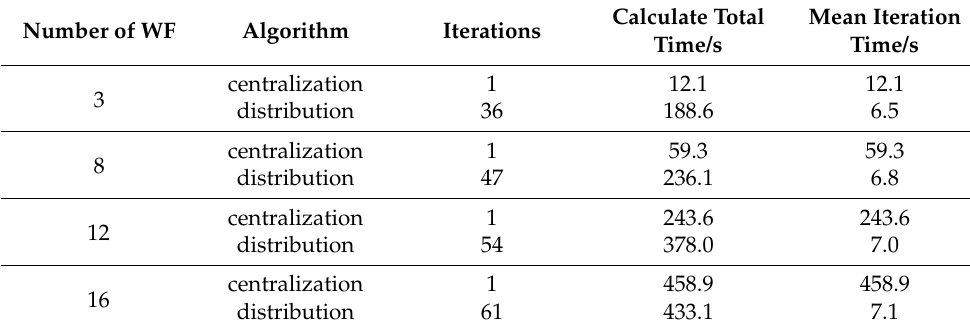
Table 3. Calculation time of different scale